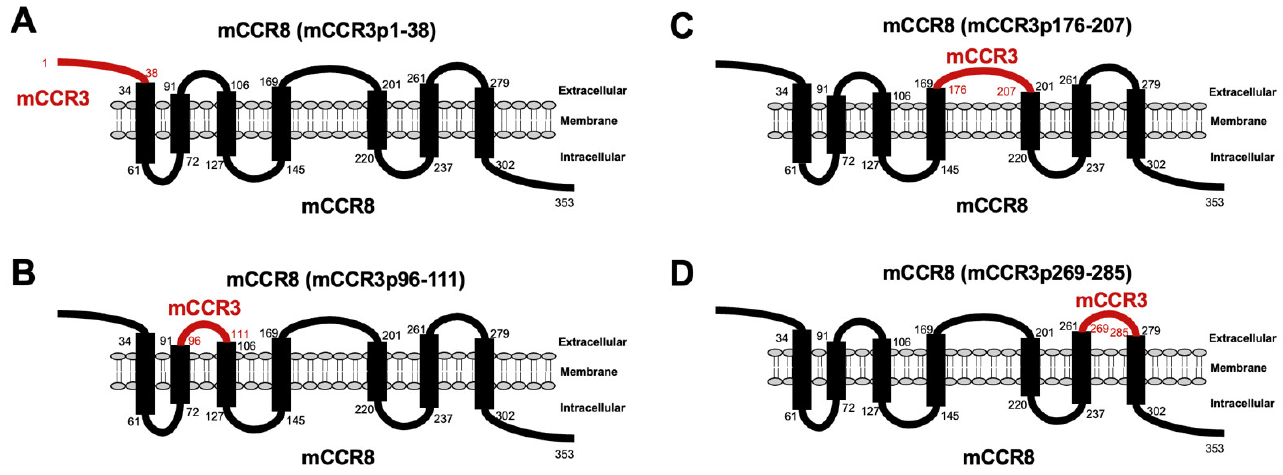
Figure 1. Schematic illustration of mCCR8 and mCCR3 chimeric proteins. The four extracellular regions of mCCR3, namely, ( A ) the N-terminal region (aa 1–38), ( B ) ECL1 (aa 96–111), ( C ) ECL2 (aa 176–207), and ( D ) ECL3 (aa 269–285), were substituted into the corresponding regions of mCCR8. ECL, extracellular loop, aa; amino acids.